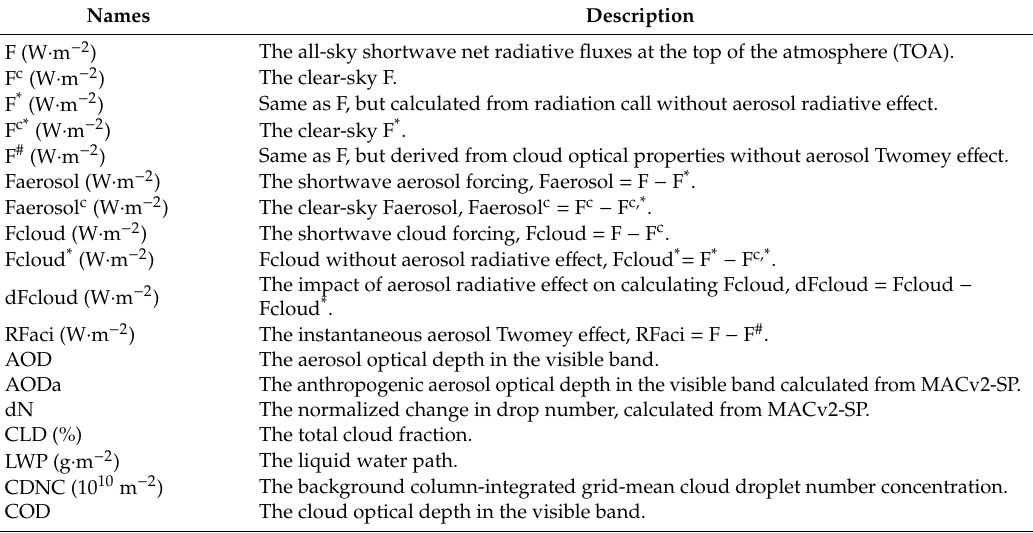
Table 2. List of model output variables analyzed in this